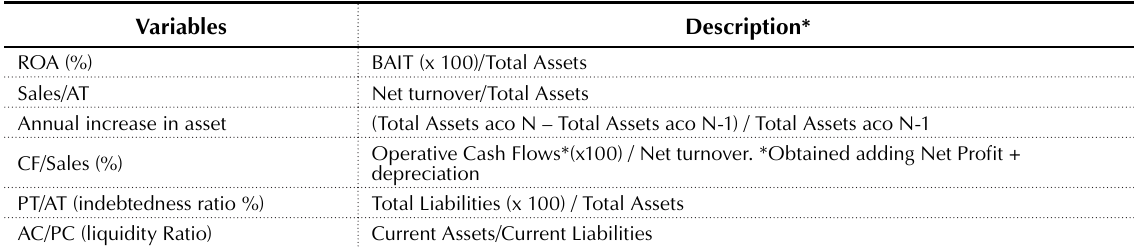
Table 1. Description of Laitinen (1991) research ratios